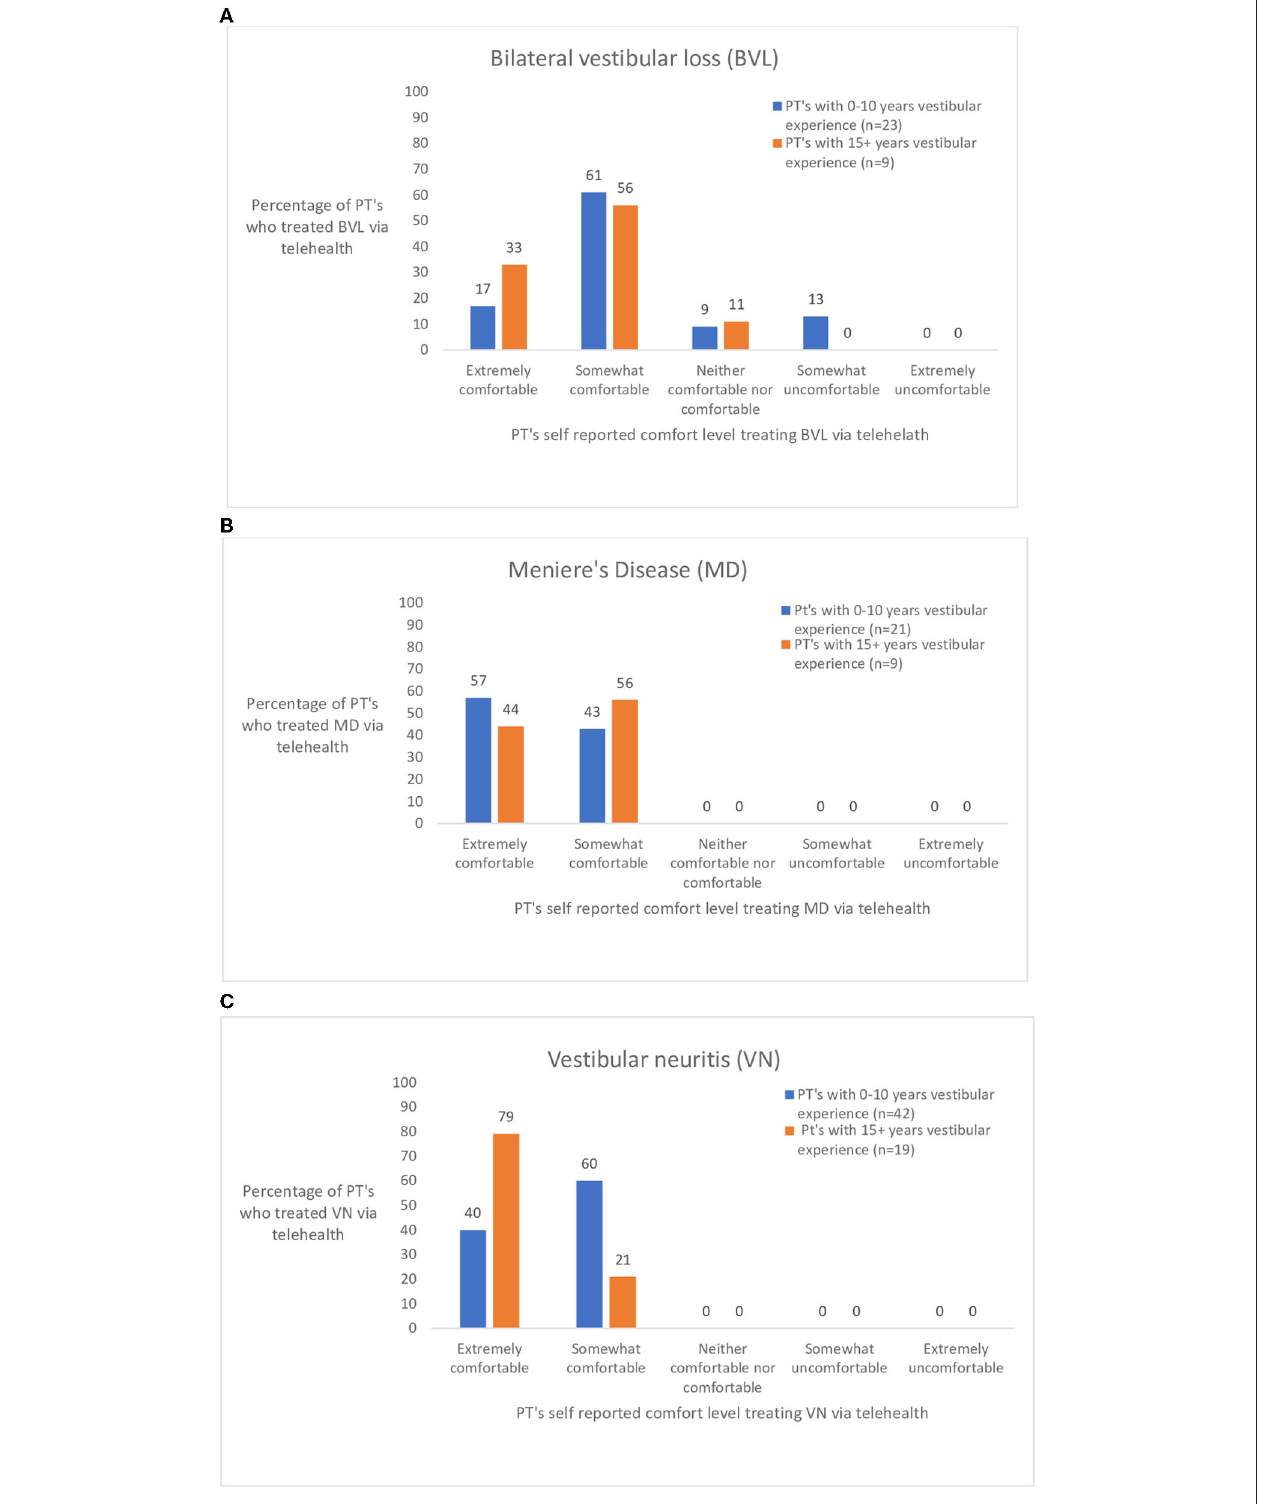
FIGURE 3 | (A–C) Ratings by physical therapist (PT’s) with 0–10 and 15 + years of vestibular experience who treated persons with common peripheral vestibular diagnoses: bilateral vestibular loss (BVL), Meniere’s disease (MD), and vestibular neuritis (VN) via telehealth.